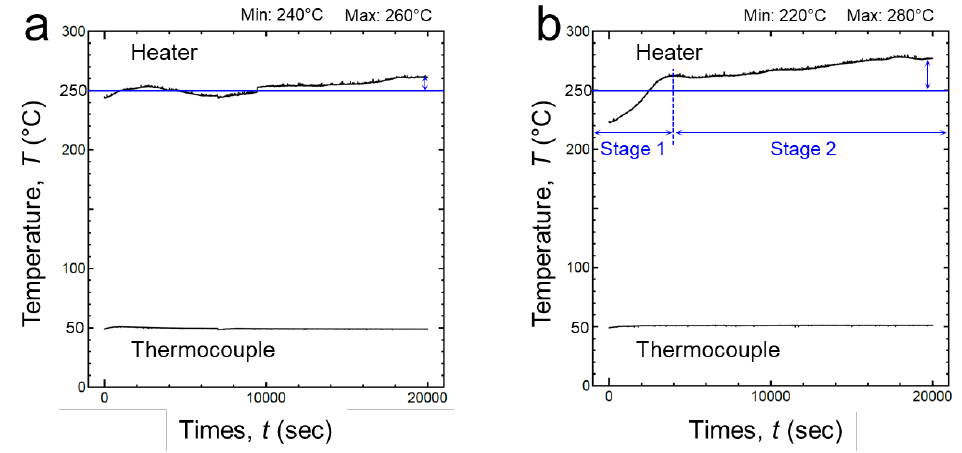
Figure 9. Temperature swing behavior during power cycling tests: ( a ) Si 3 N 4 and ( b ) AlN.